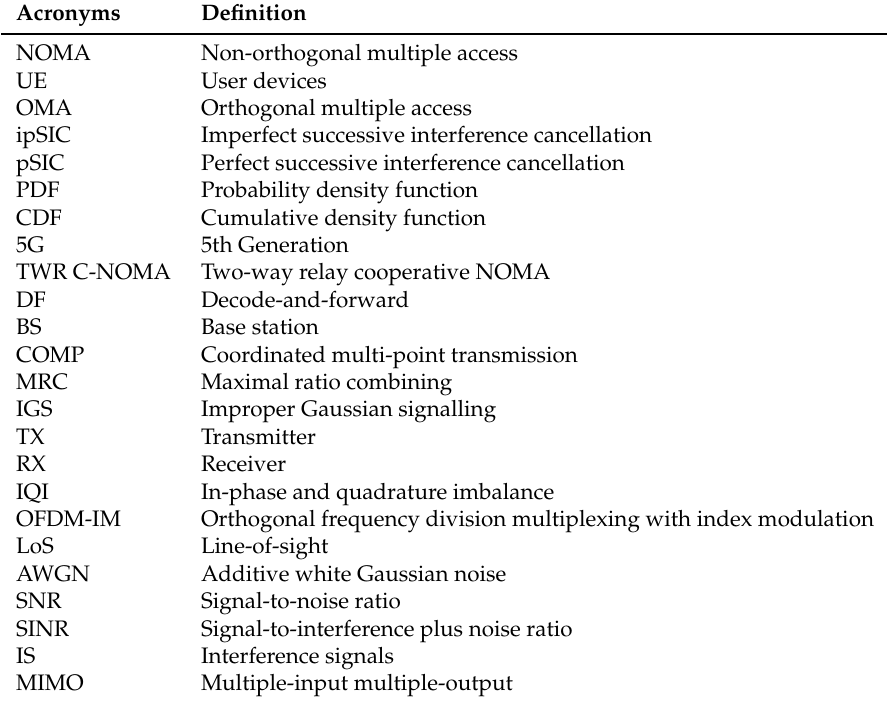
Table 1. Table of acronyms.